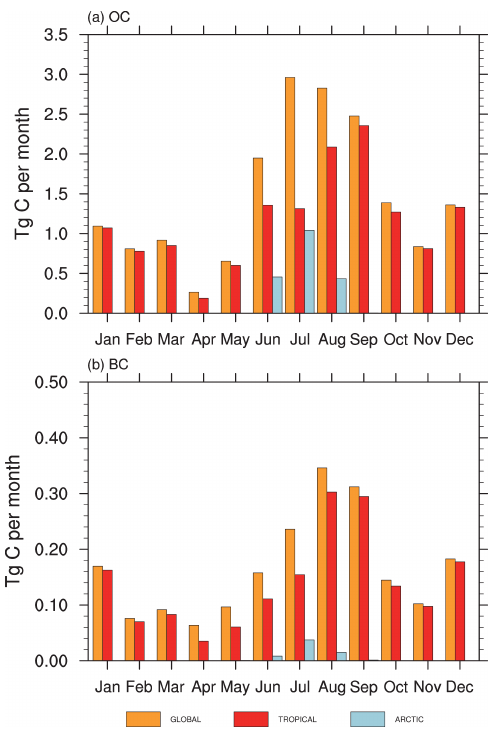
Figure 1. Seasonal variation of GFED monthly fire (a) organic car- bon (OC) and (b) black carbon (BC) emissions (TgCmonth − 1 ) av- eraged for the period of year 2003 to 2011 in the global, tropical (25 ◦ S to 25 ◦ N) and the Arctic (60 to 90 ◦ N)